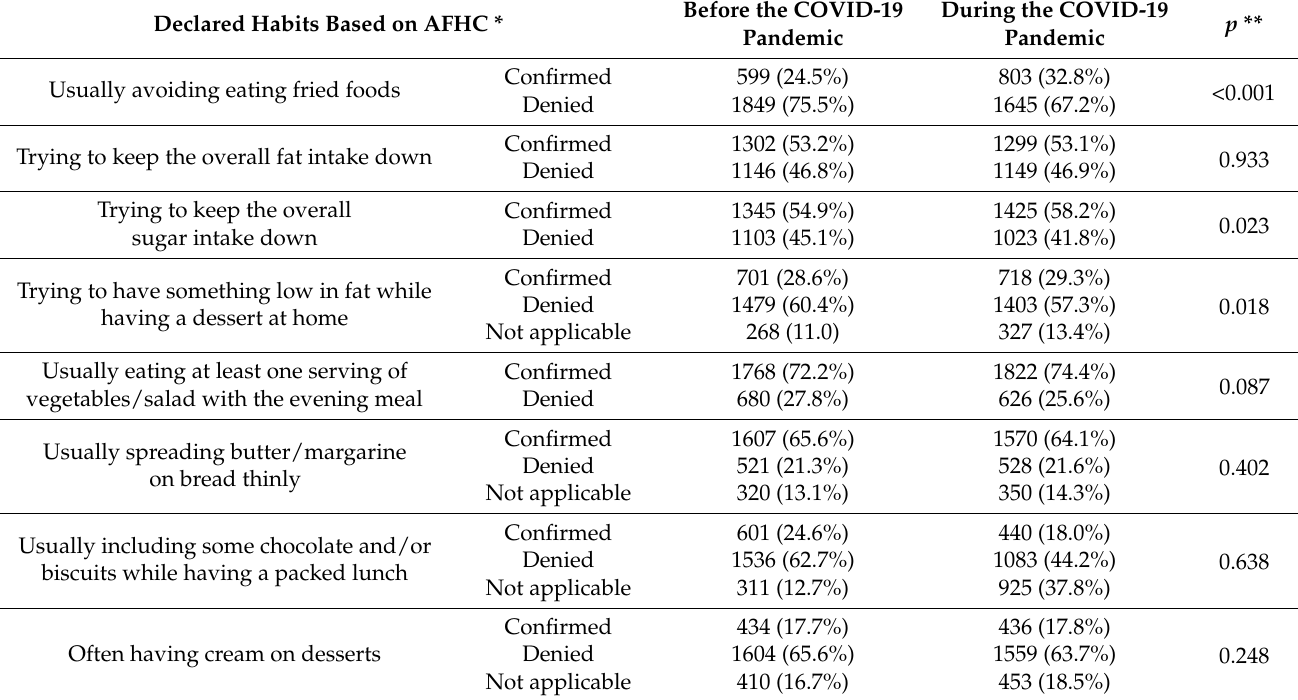
Table 3. The food preparation dietary habits assessed on the basis of the Adolescents’ Food Habits Checklist (AFHC) within the PLACE-19